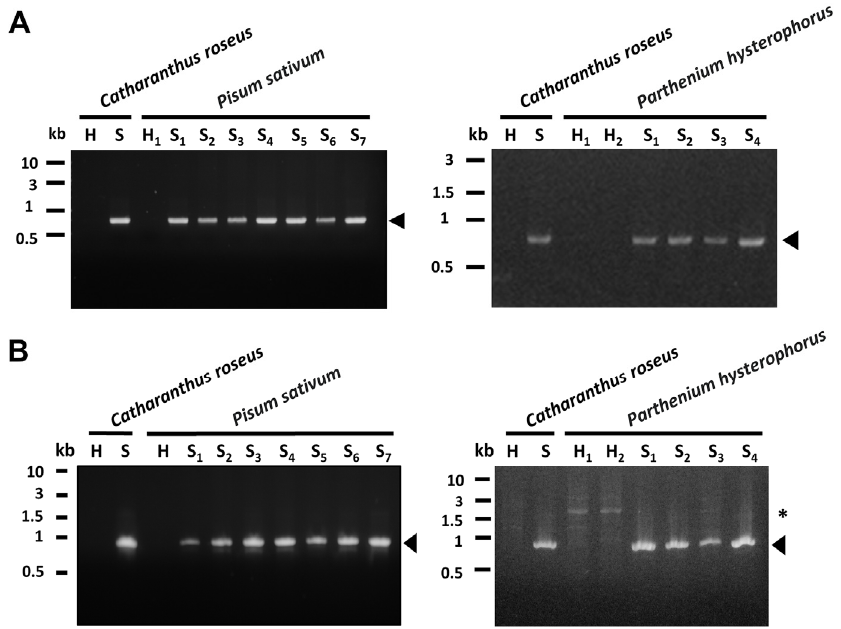
Figure 6. PCR analyses of PHYL1 and SAP11 genes from phytoplasma-infected Pisum sativum (green pea) and Parthenium hysterophorus (parthenium weed). DNA samples prepared from healthy-looking (H) and symptomatic (S) plants were used for PCR analysis. The 0.7 kb DNA fragment of phytoplasma PHYL1 gene ( A ) and the 0.9 kb DNA fragment of phytoplasma SAP11 gene ( B ) are indicated by arrowhead. Non-specific bandings are indicated by asterisk. Catharanthus roseus infected by the 16SrII-V subgroup ‘ Ca. P. aurantifolia’ NCHU2014 was used as a positive control.